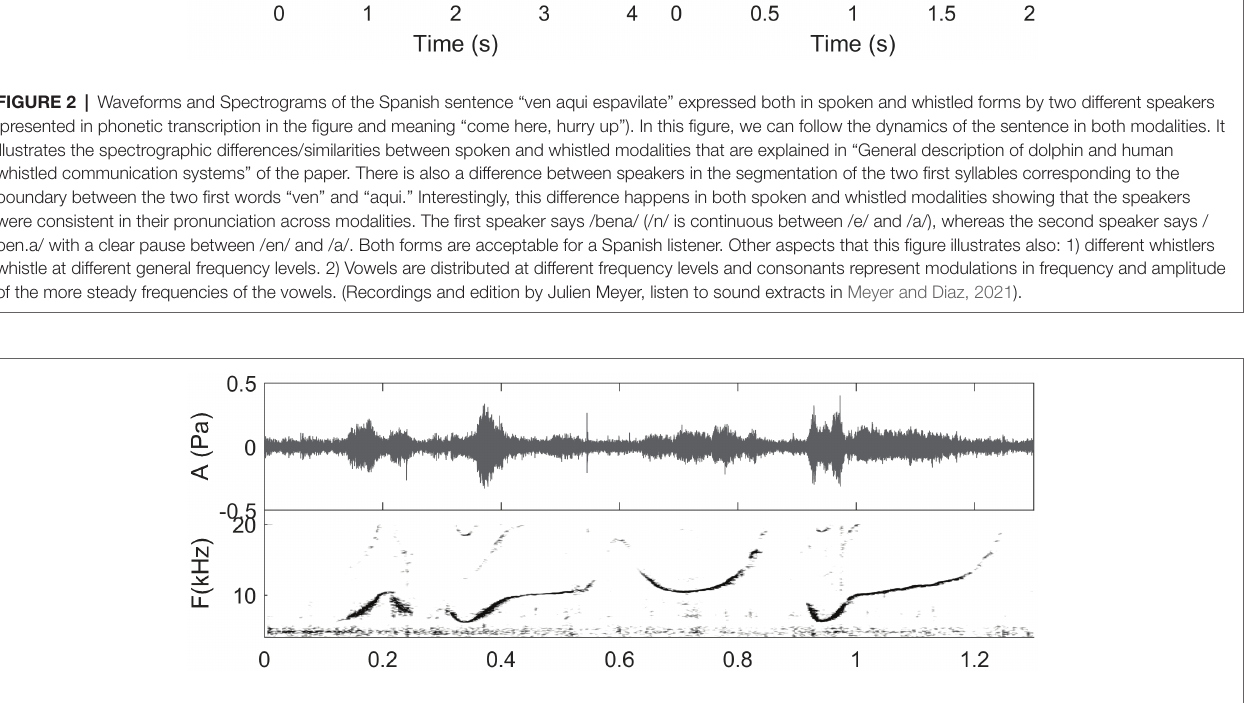
FIGURE 3 | Spectrogram of a whistle sequence produced by a solitary female bottlenose dolphin at Turneffe Atoll, Belize, the field site of co-authors (MM & DR). (Unpublished data, recording captured by E. Ramos in the DR & MM collaborative research program, listen to sound in Reiss and Magnasco,